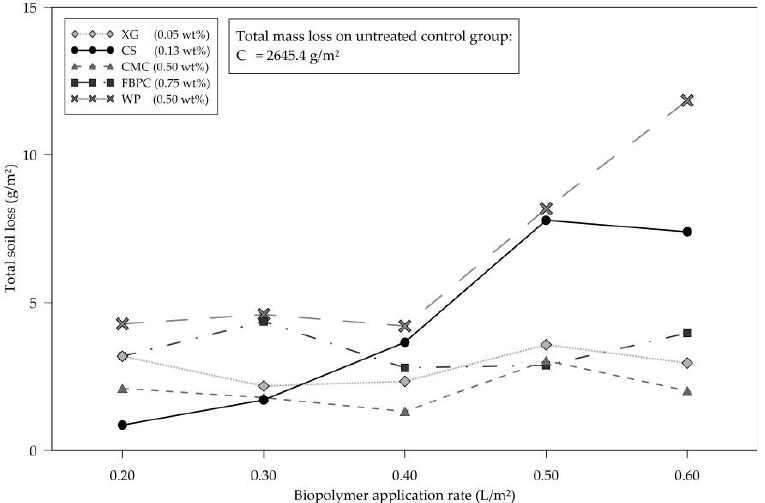
Figure 6. Total soil loss (g/m 2 ) of medium-grained sand treated at their plateau concentration at different biopolymer application rates. Tests were performed in triplicate (n = 3). Note, numerical data (mean (M) and standard deviation (SD)) are appended in Table A2. Error bars representing the SD have been deliberately omitted for better legibility.